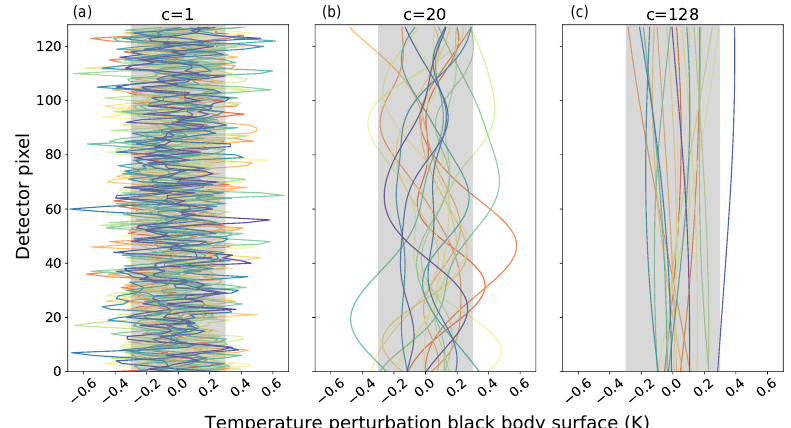
Figure 4. Random temperature deviations for the 128 vertical detector pixels with different correlation lengths c . The temperature deviations in panel (a) have a correlation length of one vertical pixel, meaning that they are nearly uncorrelated. In contrast the temperature deviations in panel (c) are nearly fully correlated over the whole detector (correlation length of 128 pixels). In panel (b) a correlation length of 20 pixels is depicted. All variations have a standard deviation of σ = 0 . 2. The gray shade marks the 3 σ area.